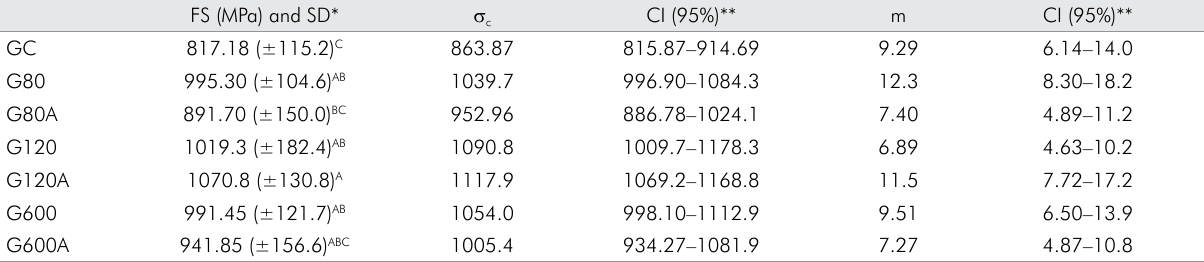
Table 3. Mean flexural strength (FS), standard deviation (SD), characteristic strength ( σ c), Weibull modulus (m), and the respective confidence intervals (CI) for each